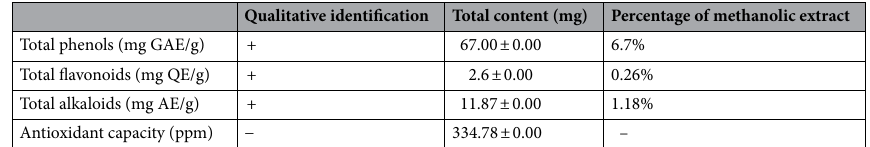
Qualitative identification Total content (mg) Percentage of methanolic